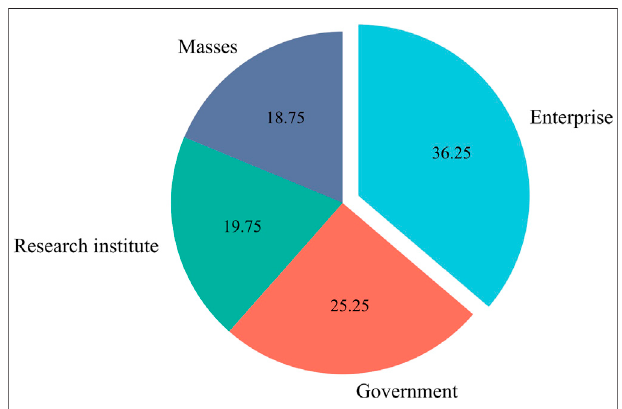
FIGURE 4 | The proportion of policy implementation